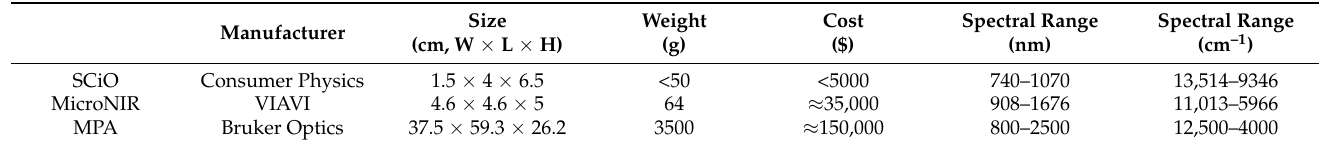
Table 1. Main technical features of the NIR spectrometers (also reported in [12]).